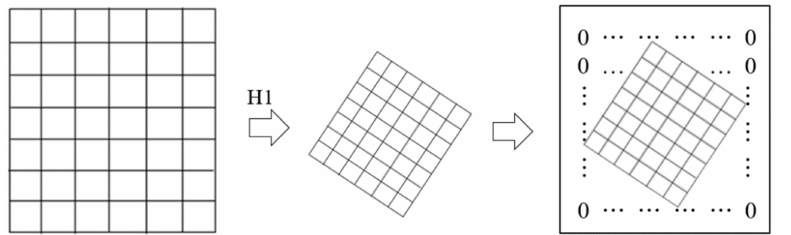
Figure 6. Schematic diagram of image preprocessing: H1 is the transformation matrix calculated via preliminary